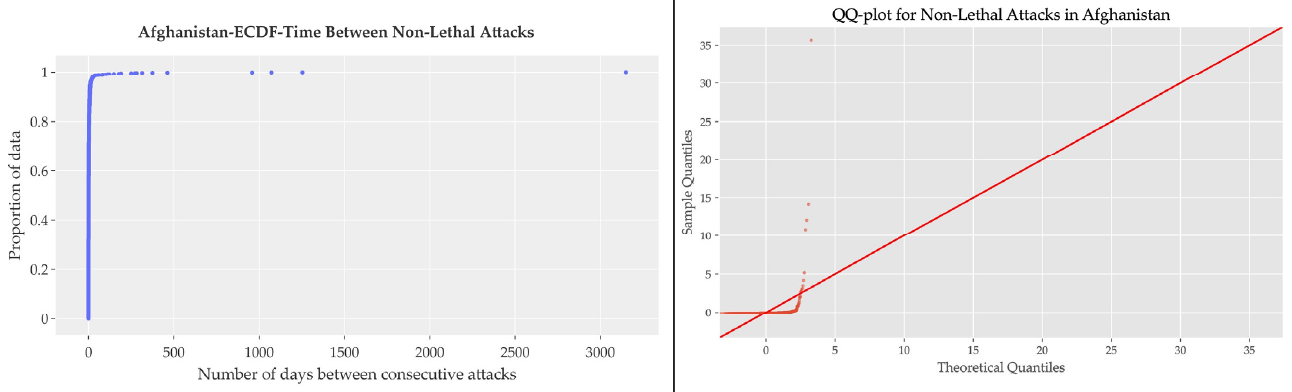
Figure 4. The time between consecutive non-lethal attacks and the corresponding QQ plot for Afghanistan.